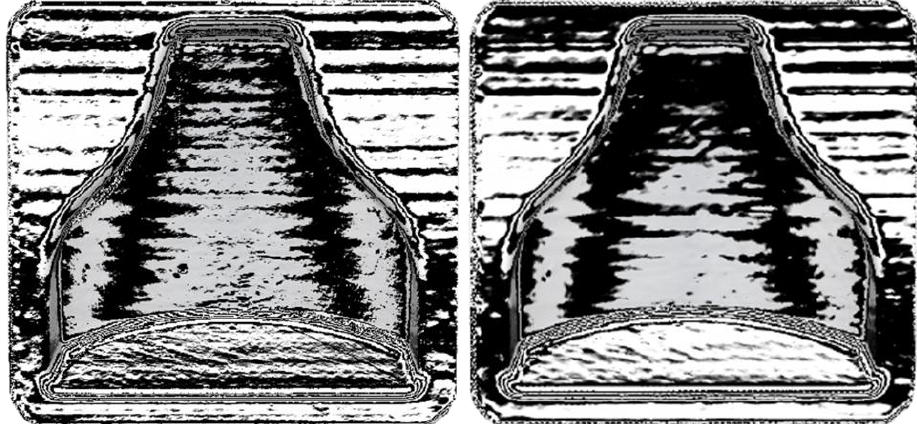
Figure 12. Zebra stripes effect on the two molds after printing. ( left ) mold 1 and ( right ) mold 2.